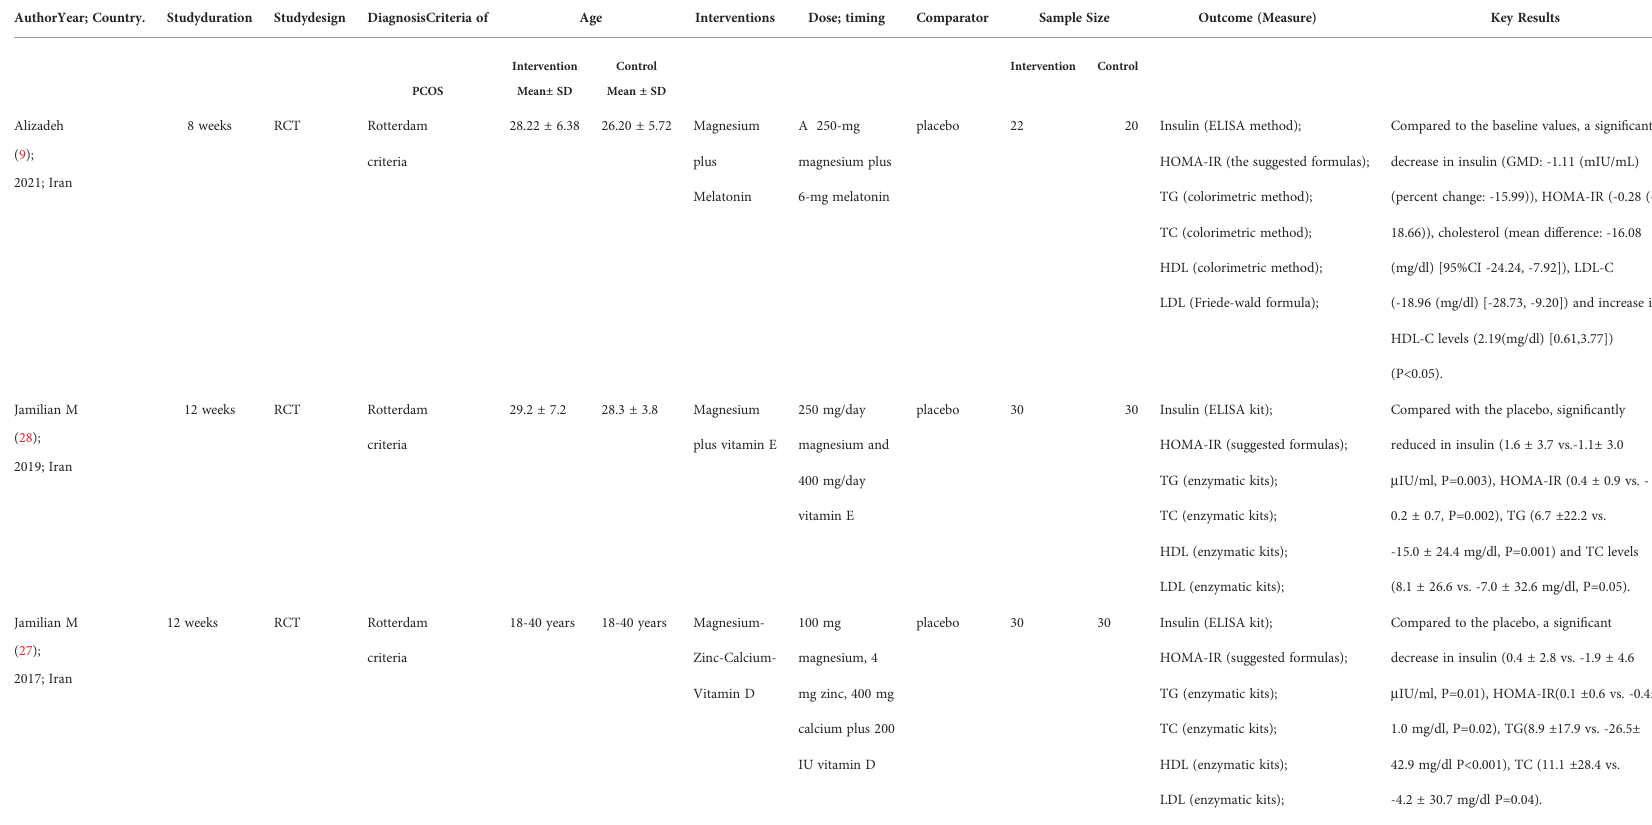
TABLE 3 Summary the characteristics of studies on the impact of combined magnesium supplement on in fl ammation and OS of PCOS. AuthorYear; Country. Studyduration Studydesign DiagnosisCriteria